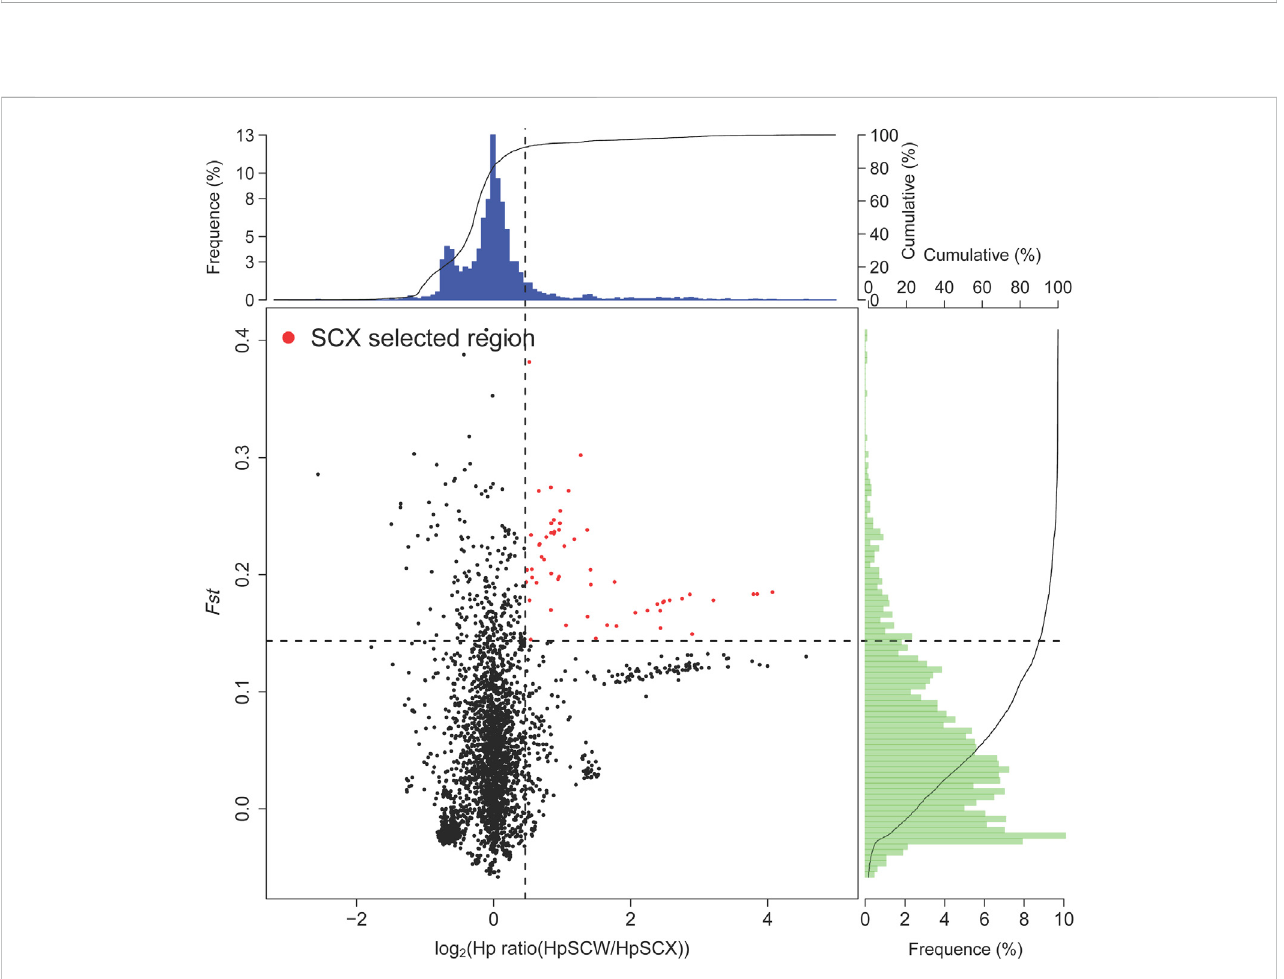
FIGURE 3 Selective sweep analysis. The regions were considered to be selected when both conditions are met: top 10% heterozygosity ( Hp ) and top 10% population differentiation coef fi cient ( Fst ).